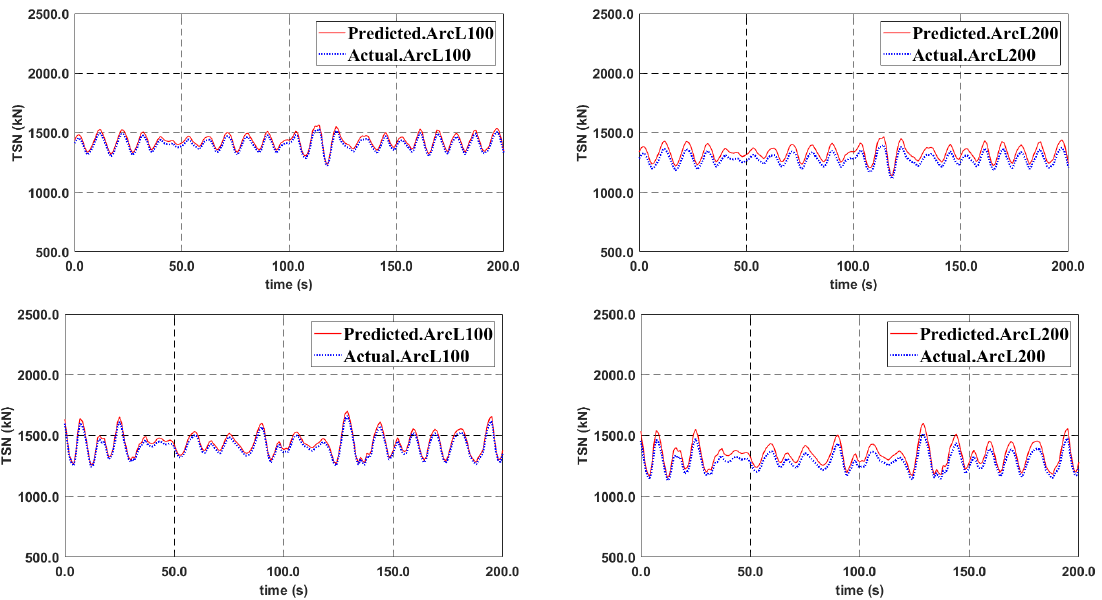
Figure 15. Tension Estimation up to Target Point, 1-yr Storm ( Up ) and 100-yr Storm ( Down ), WD1000, SLWR, Sensor Interval = 100 m.